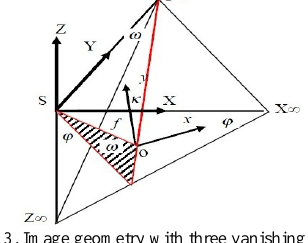
Figure 3. Image geometry with three vanishing points.